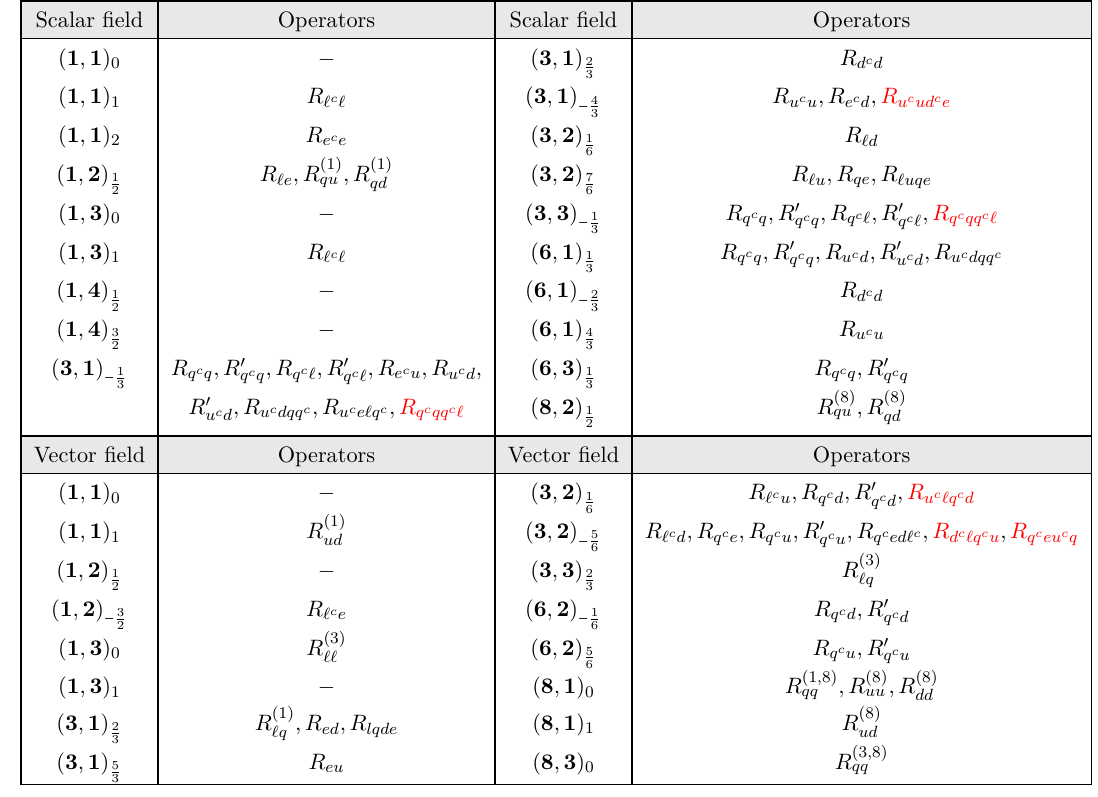
Table 3. Contributions from BSM scalars (top) and vectors (bottom) to the redundant operators. Operators that violate baryon number are highlighted in